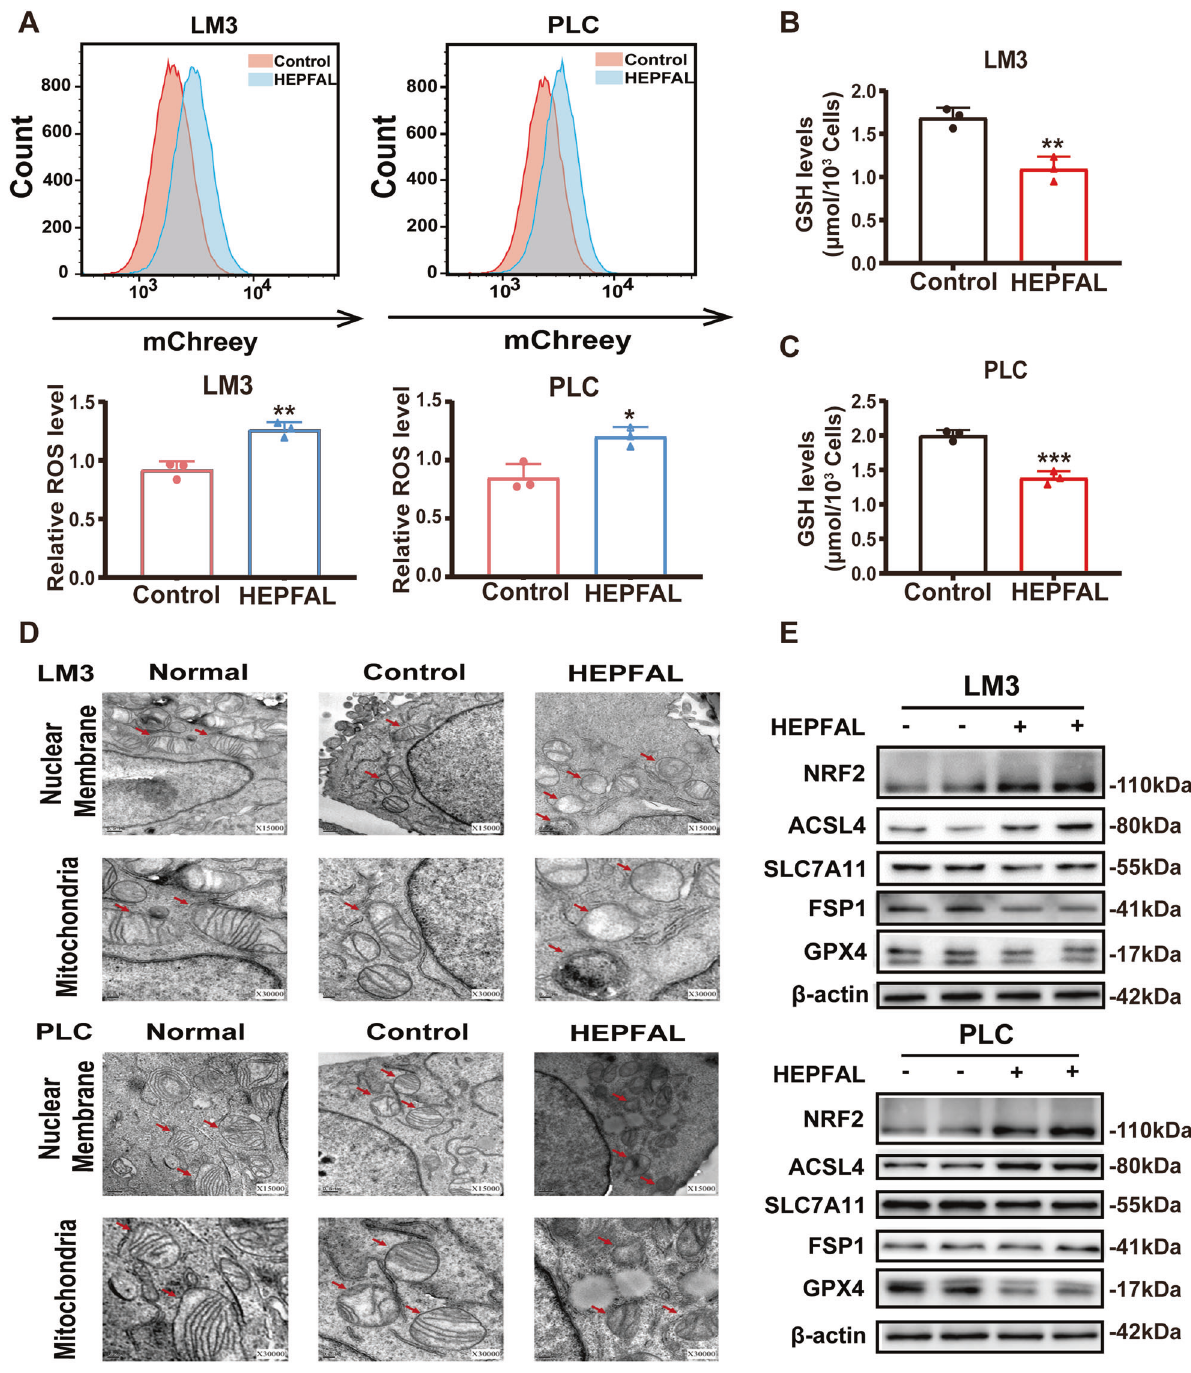
Fig. 3 Overexpression of lncRNA HEPFAL promotes cell ferroptosis. A FACS and statistical analysis of ROS level in HCCLM3 and PLC cells stably overexpressing lncRNA HEPFAL. B , C Intracellular GSH levels were examined in HCCLM3 and PLC cells treated as indicated, and bar graphs are shown. D HCCLM3 and PLC cells stably overexpressing lncRNA HEPFAL were subjected to transmission electron microscopy. Representative images are shown. E Western blot analysis of NRF2, ACSL4, SLC7A11, FSP1 and GPX4 protein level in HCCLM3 and PLC cells transfected with lncRNA HEPFAL expression vector and control vector. * P < 0.05, ** P < 0.01, *** P <